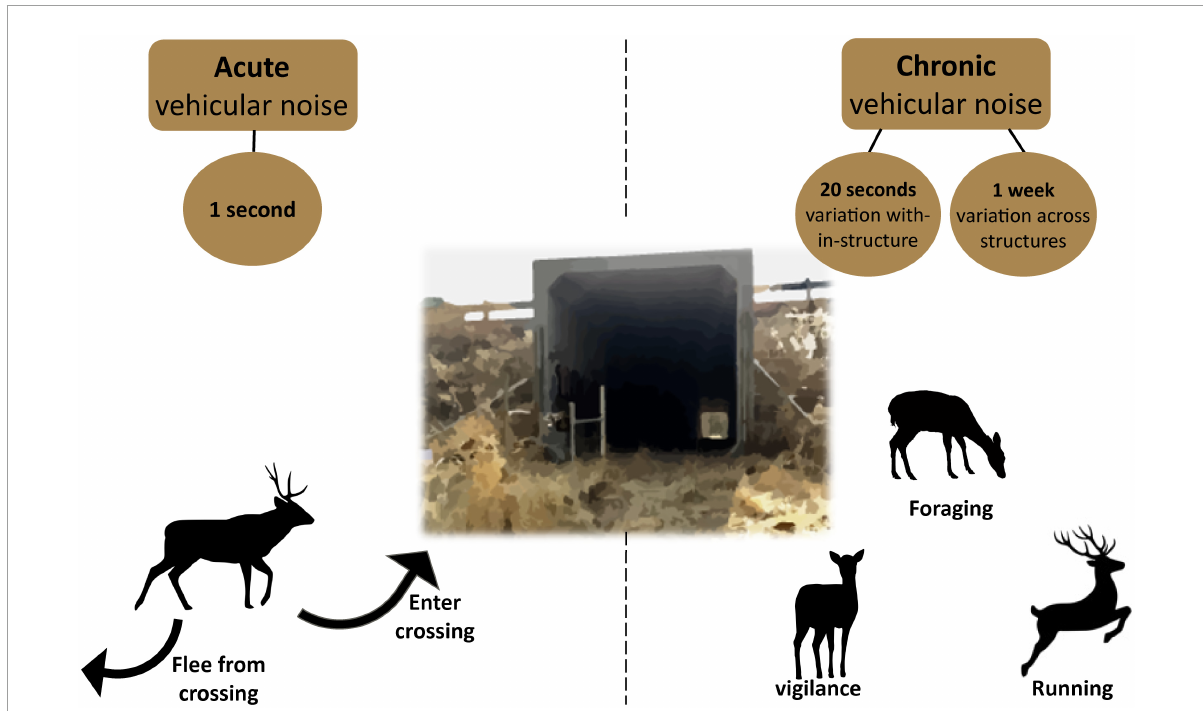
FIGURE2 Schematic representing the range of spatial and temporal scales of noise sampled at crossing structures: acute noise (1 s before and after the event), chronic noise across observations within each crossing structure (–20 s) and chronic noise across each structure (1 week). For acute and chronic noise, we illustrate the behavioral responses of mule deer and coyote that were